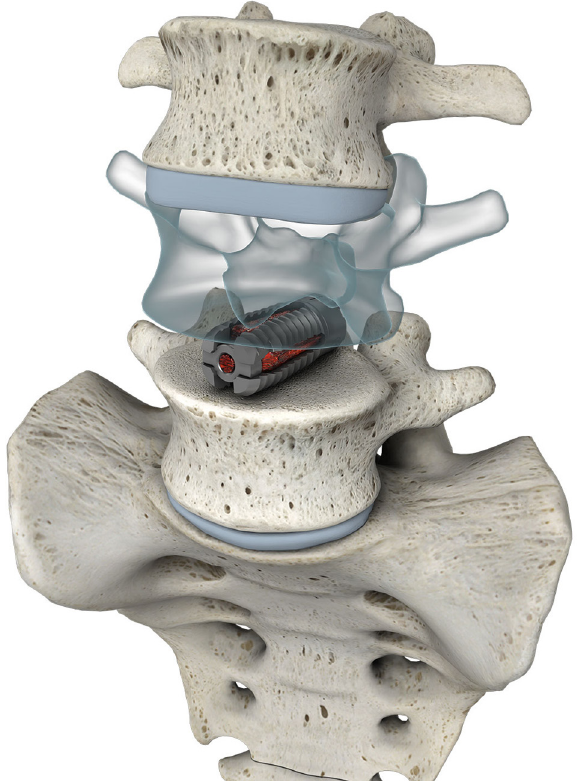
Figure 1. VariLift ® -LX expandable stand-alone lumbar interbody fusion device (Wenzel Spine, Austin, TX, USA).